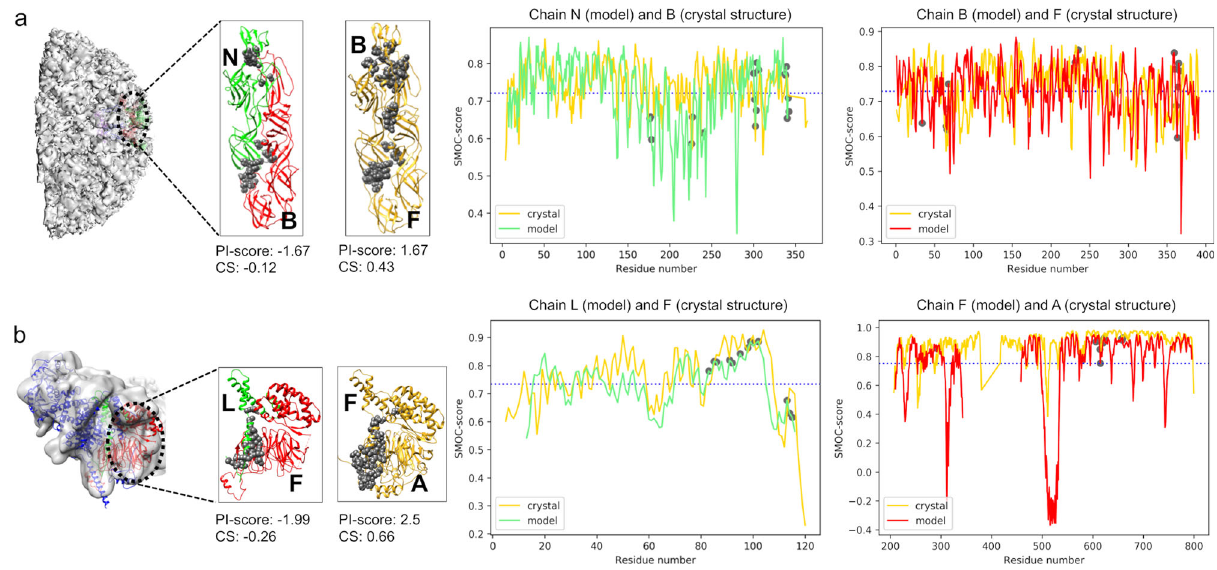
Fig. 5 Application to the fi tted models in EMDB at intermediate-low resolution. The chains from the crystal structure are in gold and the chains from the modelled structure are in red and green. The interface residues are shown as grey spheres. The plot of the local density-based score (SMOC) is shown for the chains forming an interface in the model and the equivalent chain in the crystal structure. The X-axis is numbered as per residue numbers in the crystal structure. The average SMOC over the model chain is shown as a blue dashed line. a 5 Å resolution structure of Chikungunya virus and the subcomplex envelope1 – envelope2 heterodimer (E1 – E2) (EMD-5577; fi tted PDB: 3J2W). The corresponding 2.35 Å resolution crystal structure is PDB: 3N44 (gold). b 9.8 Å resolution structure of the TFIID subunit 5 and 9 sub-complex (EMD-9302, fi tted PDB: 6MZD, cyan and green). The 2.5 Å corresponding crystal structure for subunit5-subunit 9 is PDB: 6F3T (gold). PI-score and CS (the weighted combined score, see ‘ Methods ’ ) are